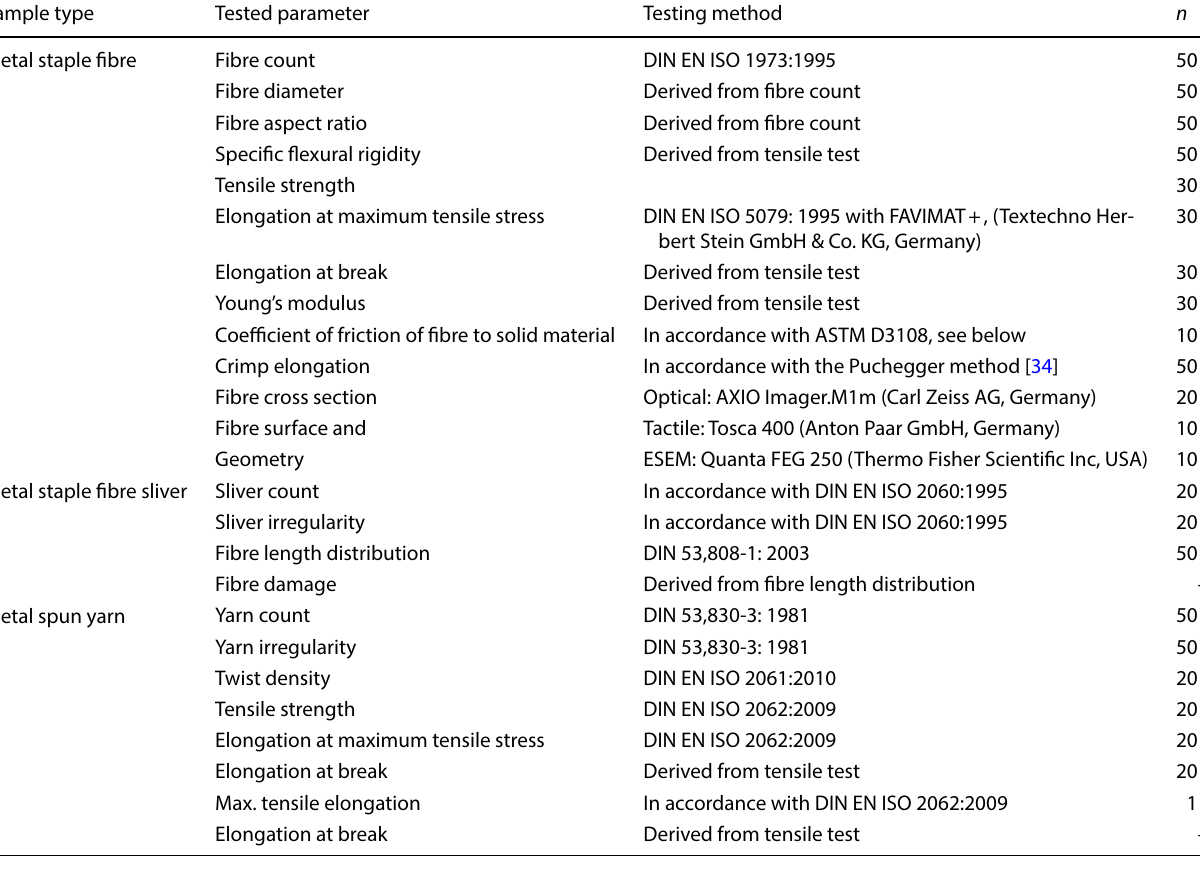
Table 2 Testing methods of the textile-physical analyses of metal staple fibres, metal slivers and metal spun yarns Sample